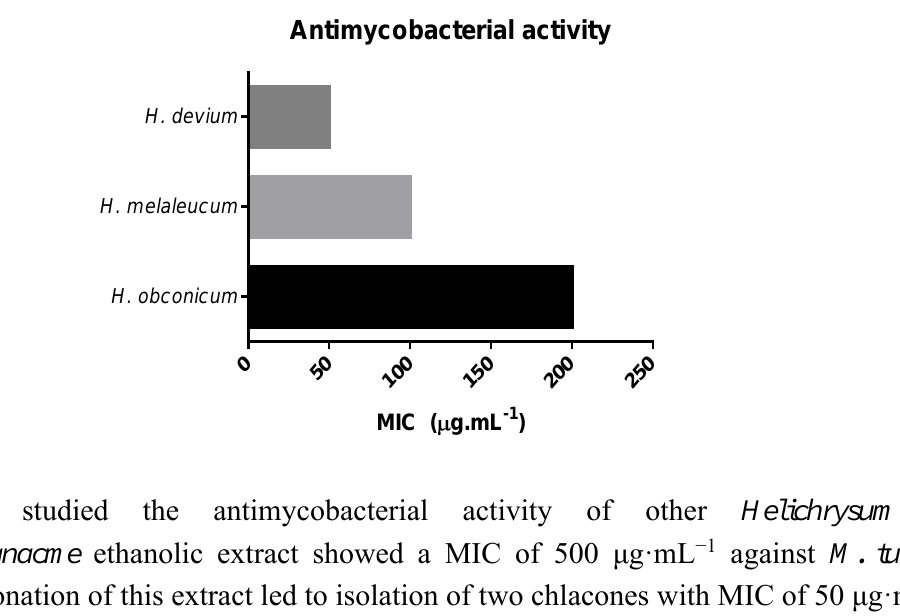
Figure 1. Antimycobacterial activity of methanolic crude extracts of Helichrysum plants. Antimycobacterial activity